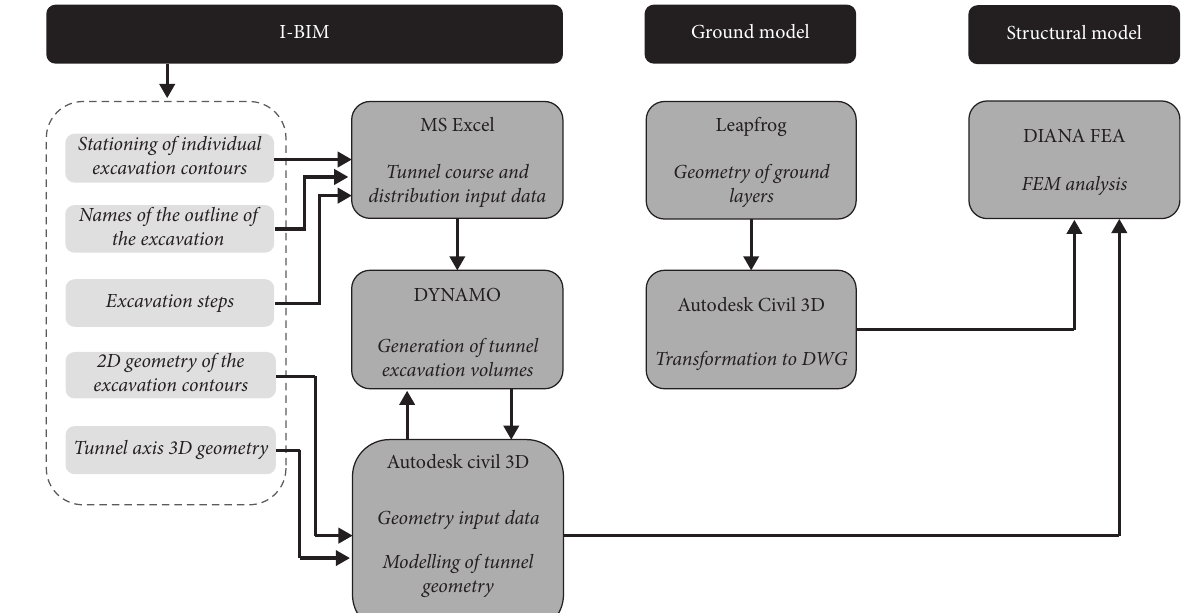
Figure 5: Schematics of the proposed method.